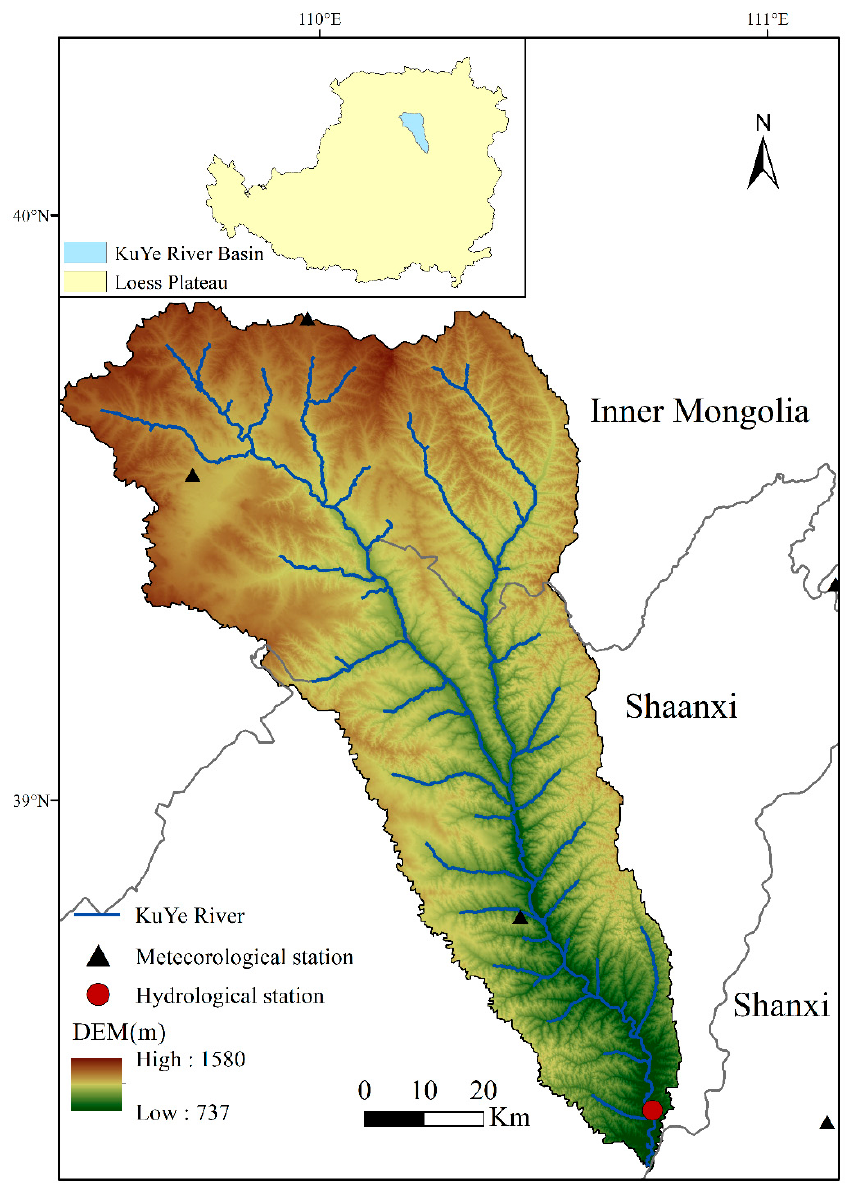
Figure 1. Topographical map of the Kuye River Basin and distribution of the meteorological and hydrological stations.